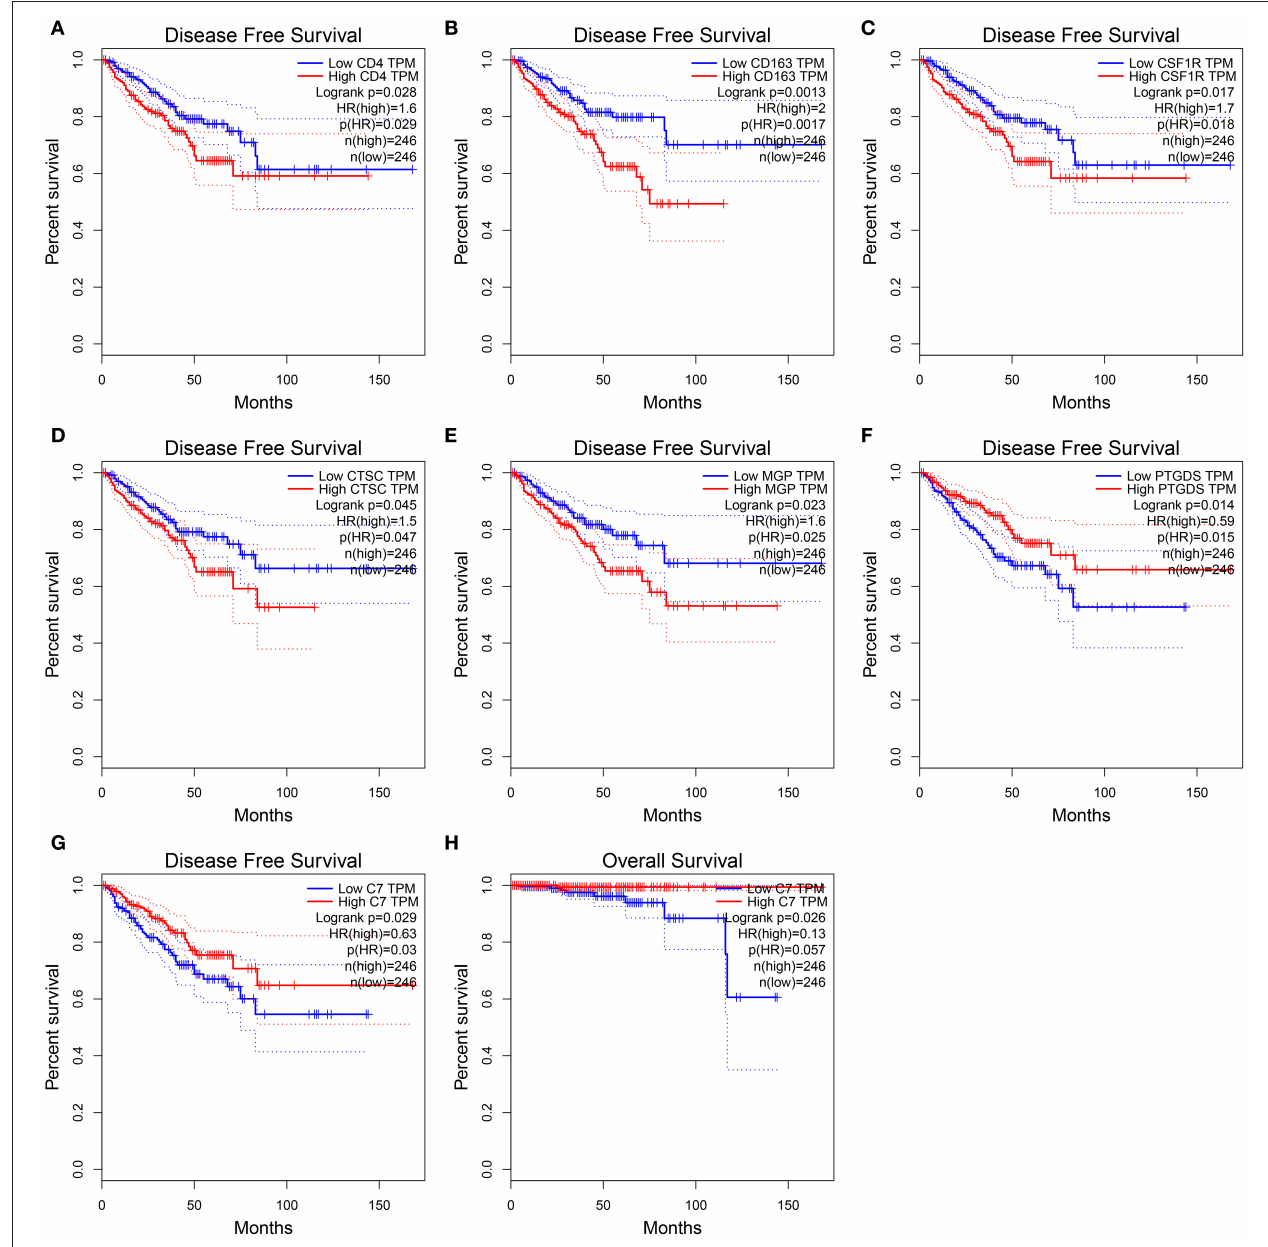
( Table S4 ), 14 CCs ( Table S5 ), and 21 MFs ( Table S6 ) including humoral immune response, cell killing, extracellular matrices,